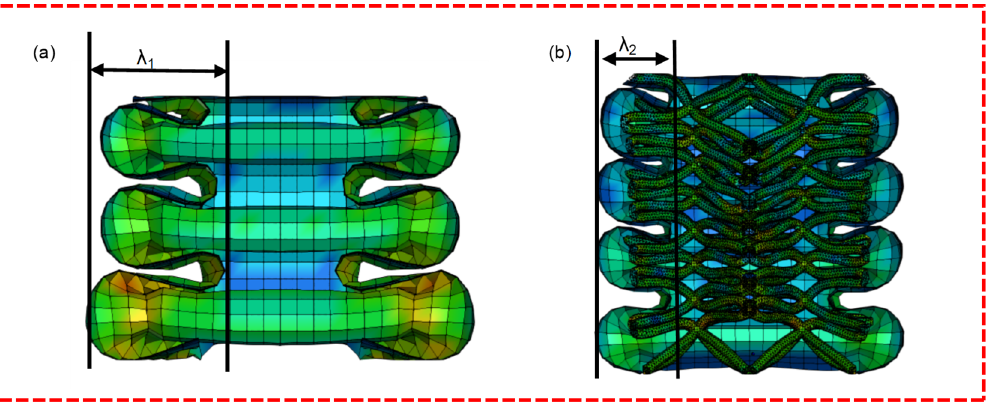
Figure 11. Numerical simulation cross section of air tube and ULT2: ( a ) Air tube structure profile, ( b ) ULT2 hybrid structure profile.